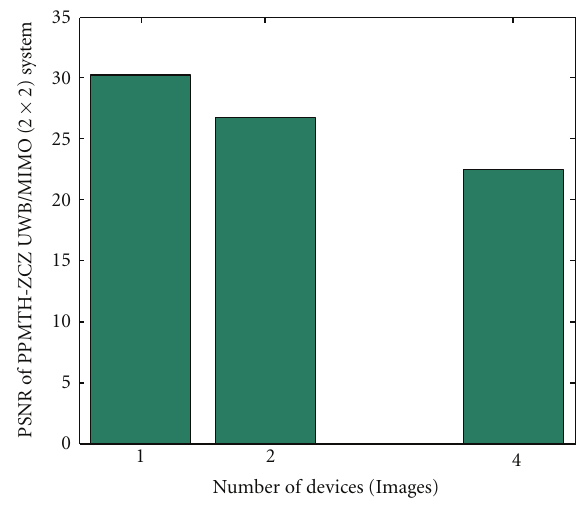
Figure 10: Histogram when input as biomedical image for PPM TH-ZCZ UWB/MIMO (2 × 2) system with multiple devices in WBAN channel